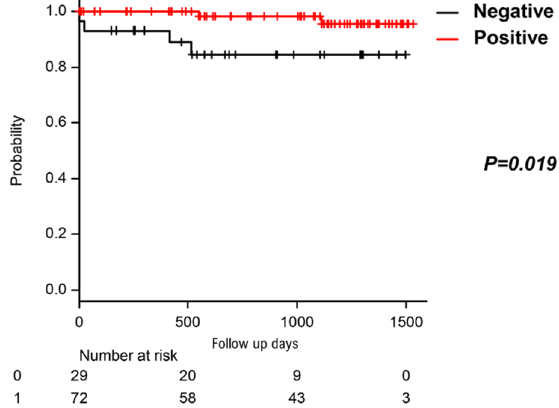
Figure 4. KAPLAN Meier curves depict the occurrence rate of unanticipated cardiac events classified according to the HUTT results. The black line stands for the patients whose HUTT was negative. The red line stands for the patients whose HUTT was positive.